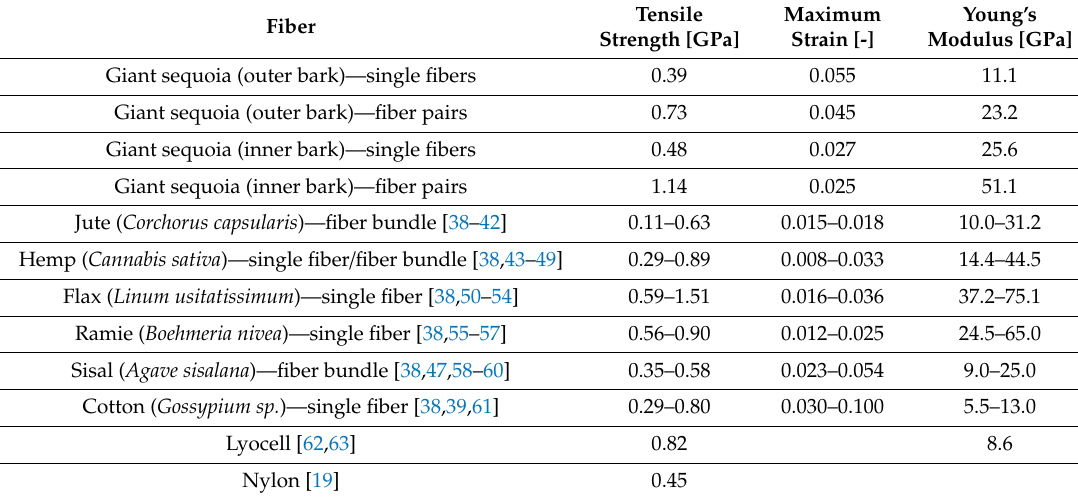
Table 1. Mechanical properties (tensile strength, maximum strain and Young’s modulus) of single fibers and fiber pairs of the outer and inner bark of the giant sequoia (median values) compared to literature values of other natural and technical